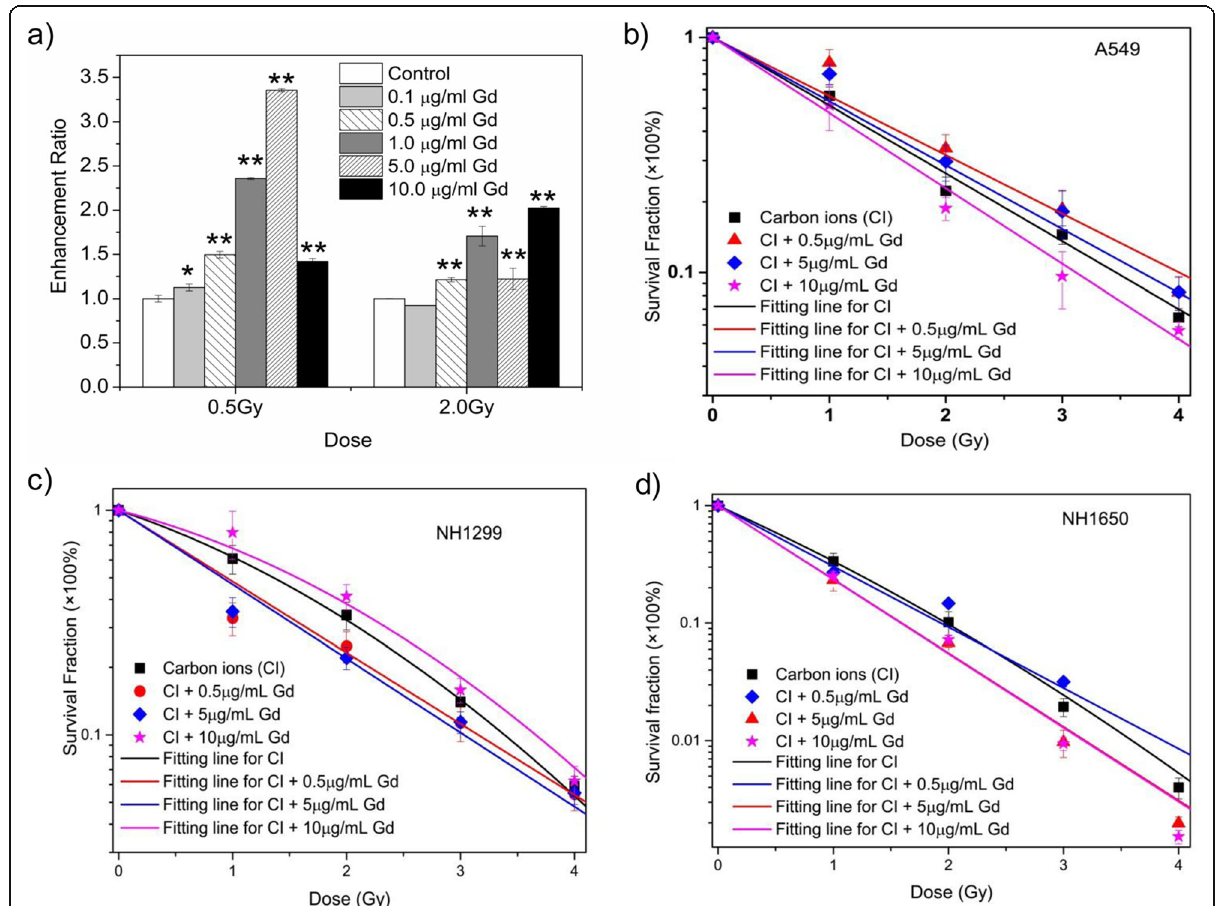
Fig. 2 The influence of GONs on hydroxyl radical production and cell survival fractions. a The dependence of hydroxyl radical production on the concentration of Gd after carbon ion irradiation. b – d The survival curve of GONs-pretreated A549 ( b ), NH1299 ( c ), and NH1650 ( d ) cells under carbon ion